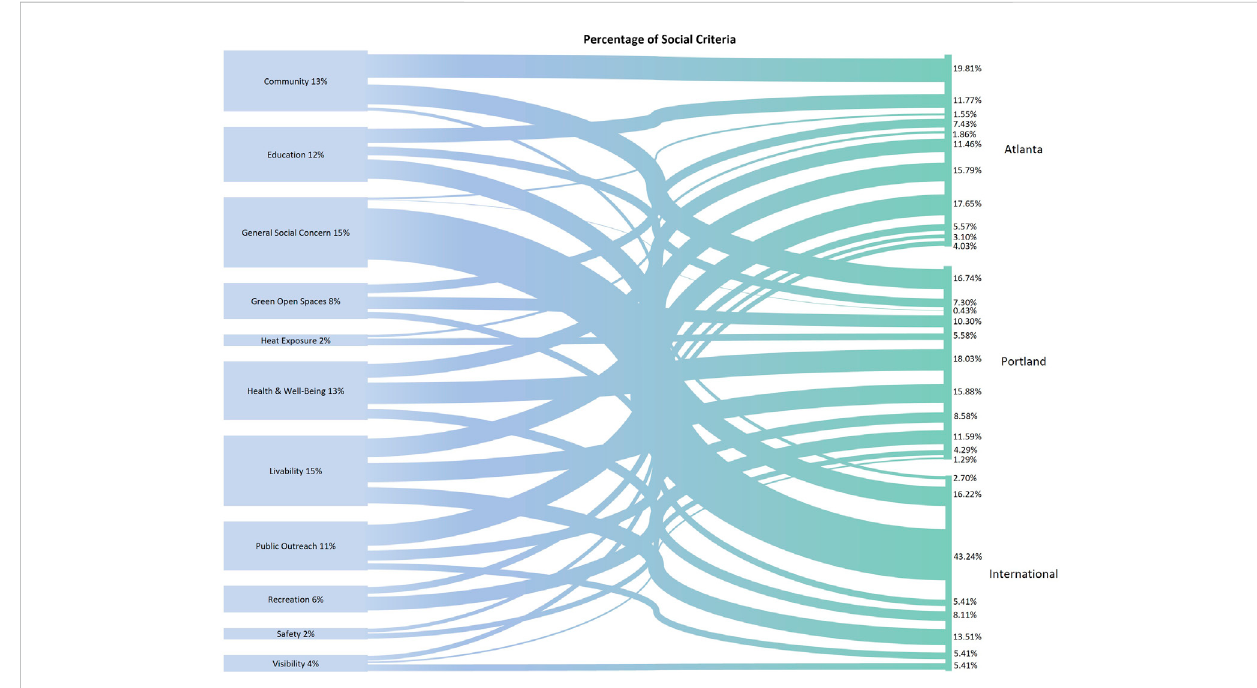
FIGURE 3 Subcategory fi ndings and comparison of Social